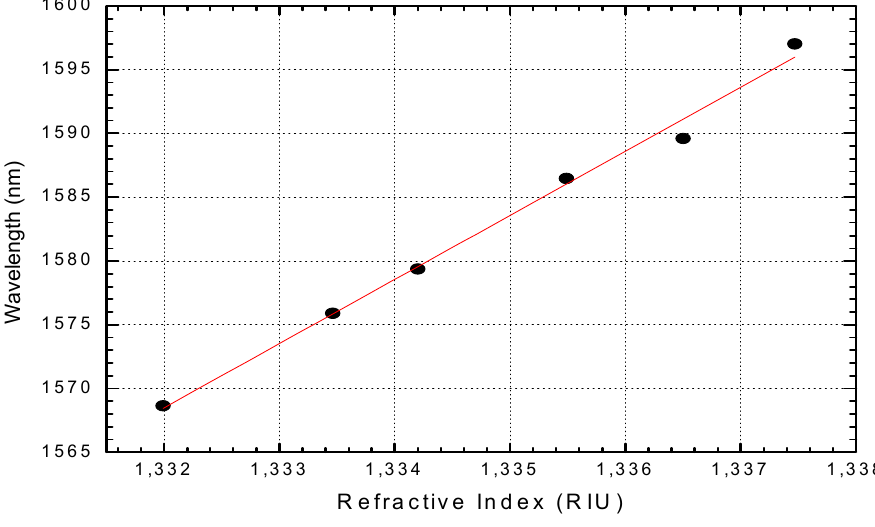
Figure 12. Peak wavelength response of the SPR sensor to different refractive index